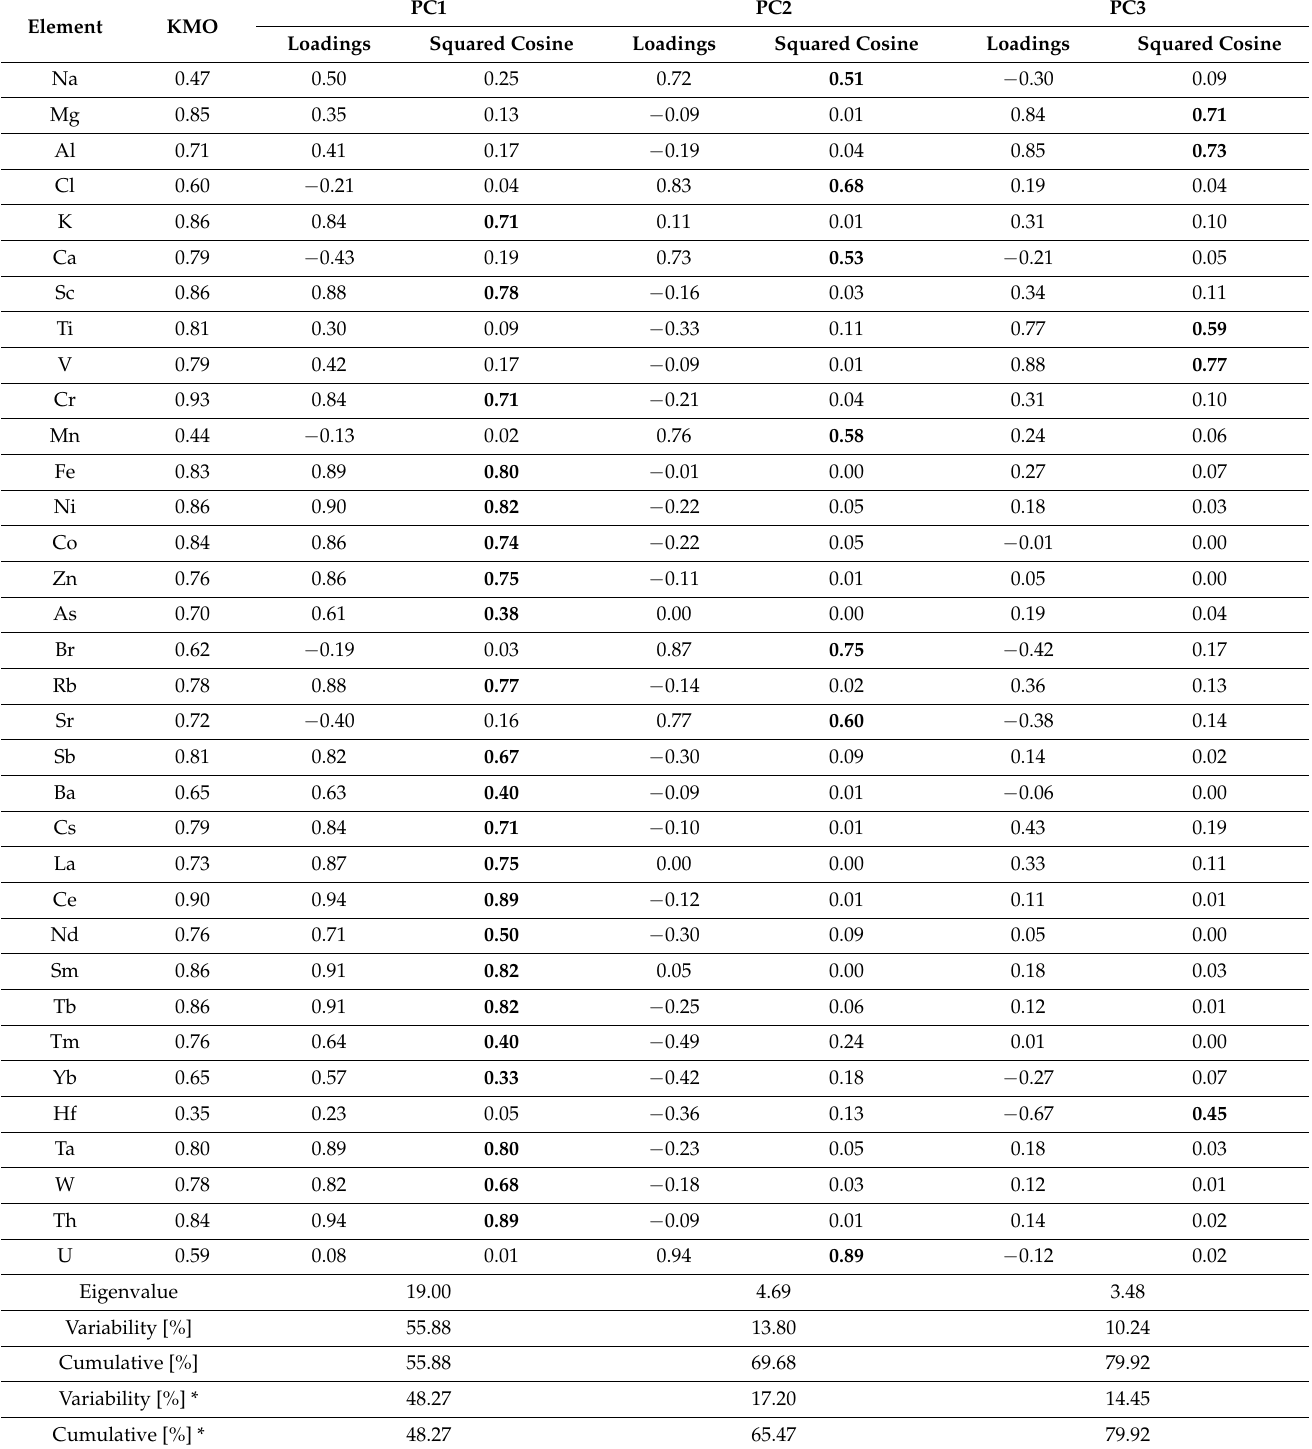
Table 7. Principal component analysis data for the elements quantified in sediment sample of Caineni